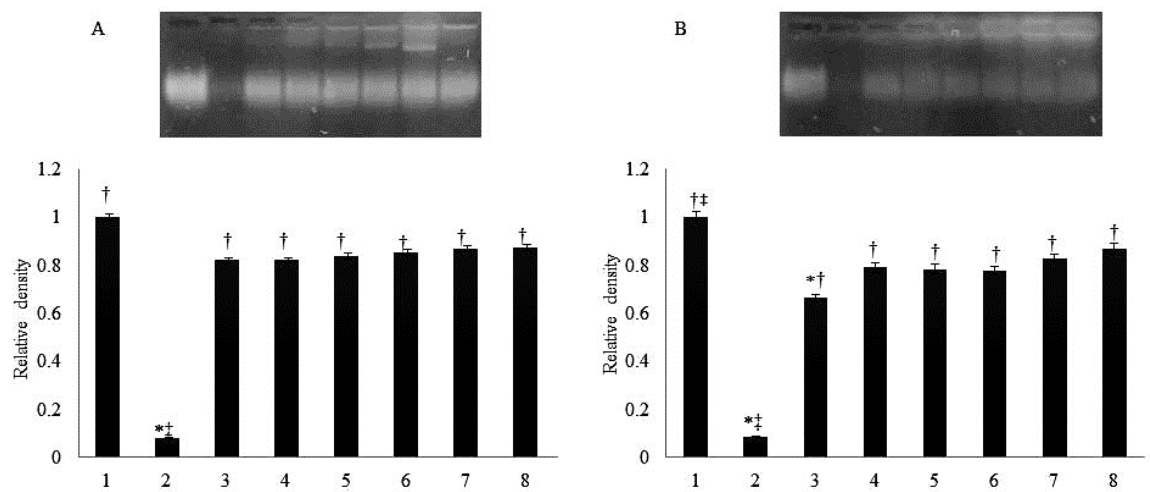
Figure 2. Protective potential of Lunaria annua aerial part (A) and root (B) extracts against hydroxyl radical-induced DNA damage. Untreated DNA (lane 1, negative control), damaged DNA (lane 2, positive control), quercetin (lane 3, 100 µg/mL, standard), L. annua extracts at the concentrations of 25, 50, 100, 200, and 400 µg/mL (lanes 4-8). * p < 0.05 when compared with the negative control group; † p < 0.05 when compared with the positive control group, ‡ p < 0.05 when compared with the reference compound.